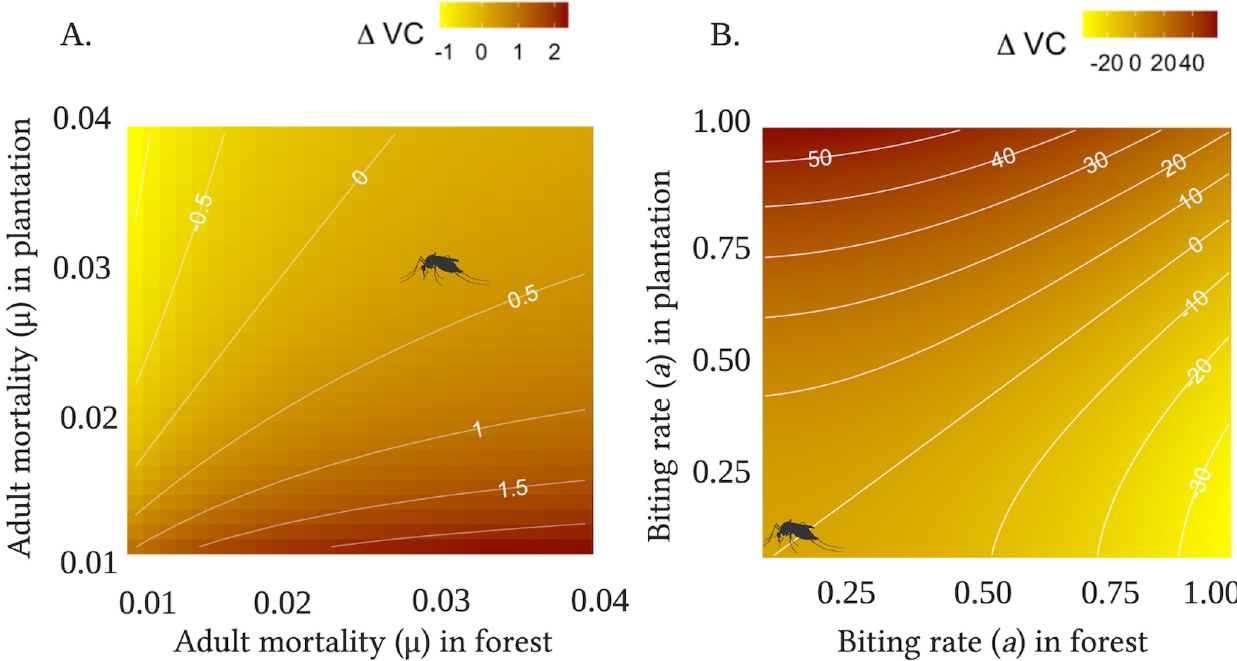
Fig 2. Effects of adult mortality (A) and biting rate (B) on vectorial capacity. Contour plot of differences in vectorial capacity estimates between oil palm plantations and logged forest, with positive values of Δ VC denoting higher vectorial capacity in oil palm plantation and negative values denoting higher vectorial capacity in logged forest. As you move along the x-axis, the respective traits increase in logged forest, and the same applies for oil palm plantation along the y-axis. The mosquito icon indicates the value of the trait observed from the empirical data. Created with Biorender.com.